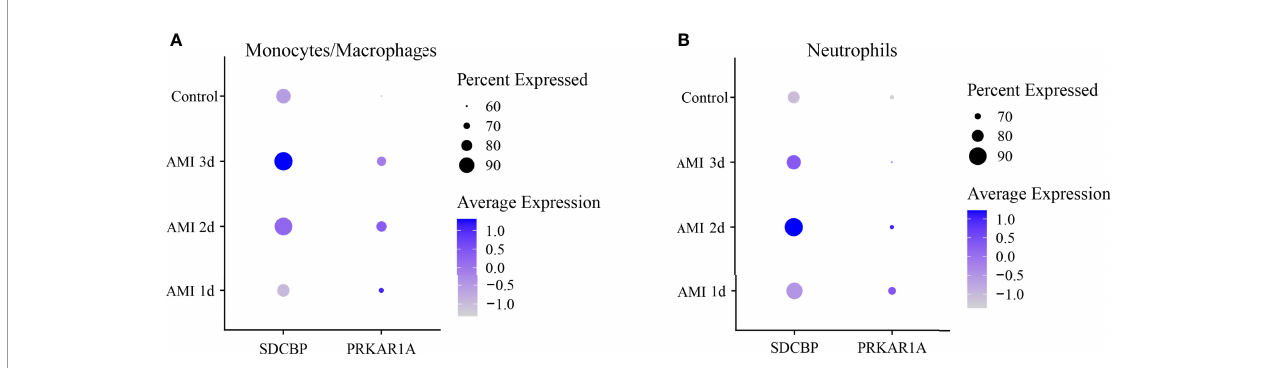
FIGURE 6 | Dot plot of expression pro fi les of PRKAR1A ( A ) and SDCBP ( B ) in monocytes/macrophages and neutrophils at different time points after AMI. Dot size re fl ects the percentage of cells expressing the markers in each cell type. The scale color represents the gene expression levels from low to high. AMI, acute myocardial infarction.